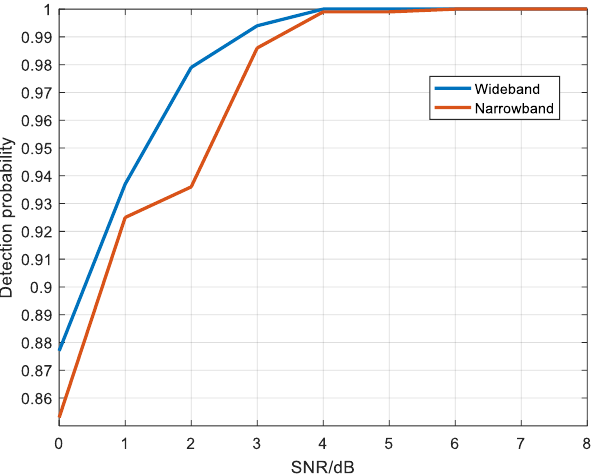
. Figure 31. Detection probability diagram of wideband and narrowband under different SNR. As can be seen from the figure, although the amplitude value of a single scattering point in wideband is smaller than that of the target echo in narrowband, the detection probability of wideband is slightly higher than that of narrowband when the SNR is low. 4.3.2. Electromagnetic Simulation Experiment Ⅱ The X-axis of the model in section 4.3.1 was rotated by 5°, the model is shown in Figure 32. Electromagnetic simulation was carried out for the echoes in the case of wideband and narrow band. The frequency is [9.5, 10.5] GHz in the case of wideband and [9.995, 10.005] GHz in the case of narrowband.